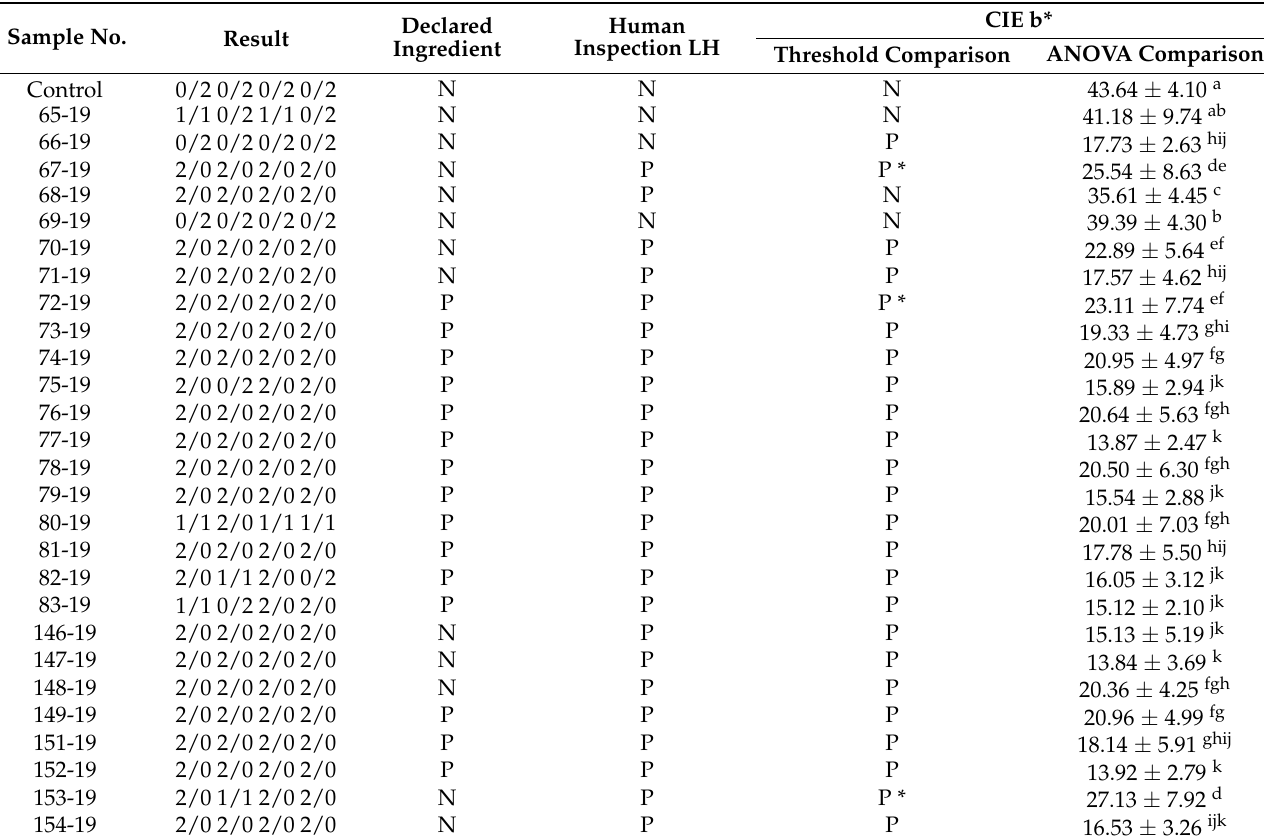
Table 4. Results comparison of the retail market samples by Human Inspection and by b* of CIE L*a*b*. Sample